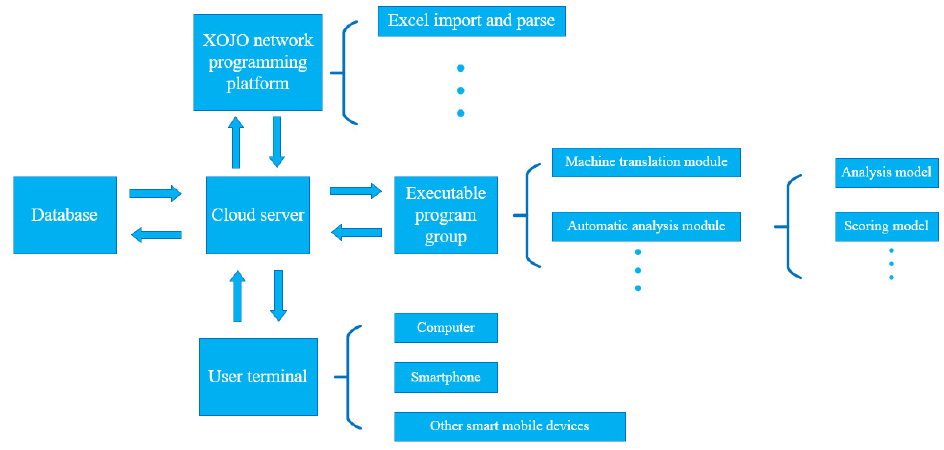
Figure 3. Cloud platform system framework.